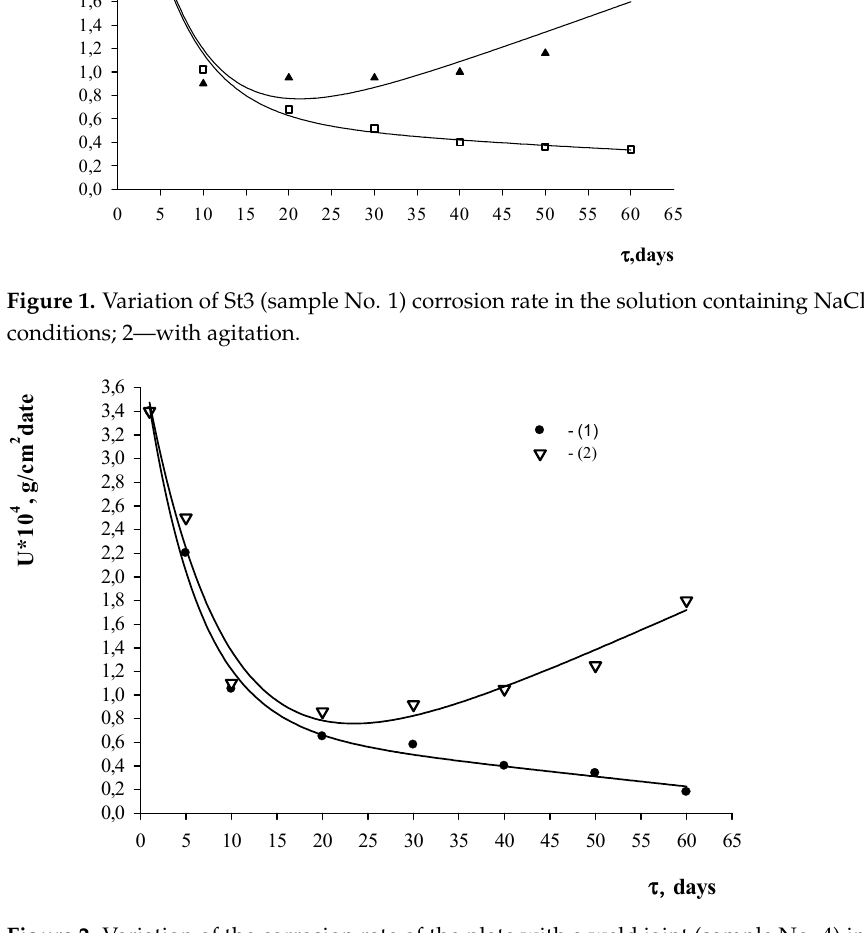
Figure 1. Variation of St3 (sample No. 1) corrosion rate in the solution containing NaCl. 1—in static conditions; 2—with agitation.